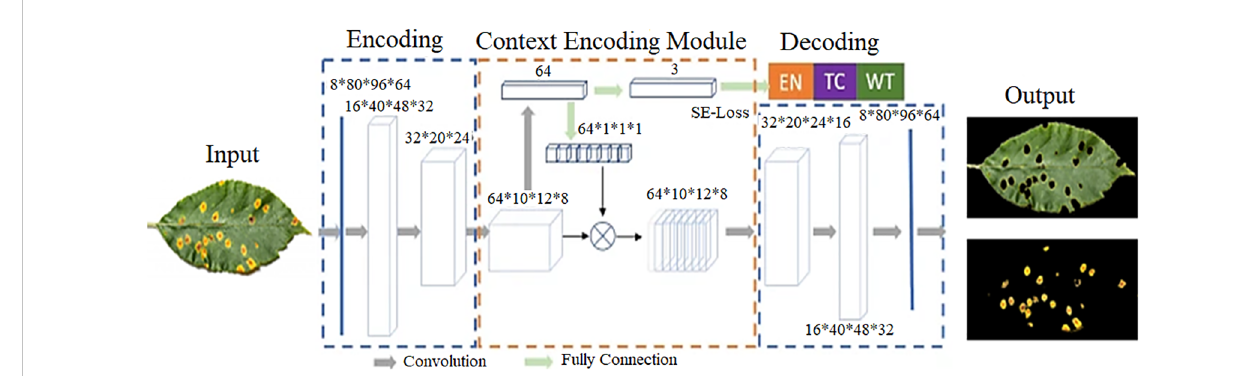
FIGURE 3 CANet neural network-based disease detection and ROI segmentation (Shoaib et al.,